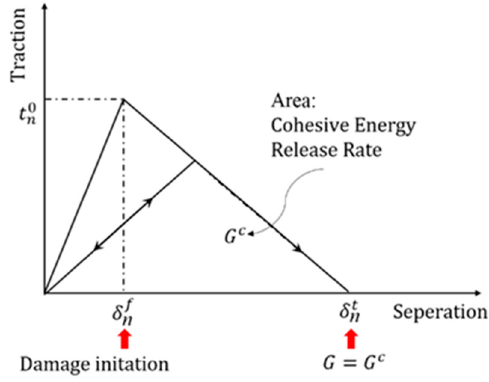
Figure 2. Cohesive linear-softening for BK criterion.